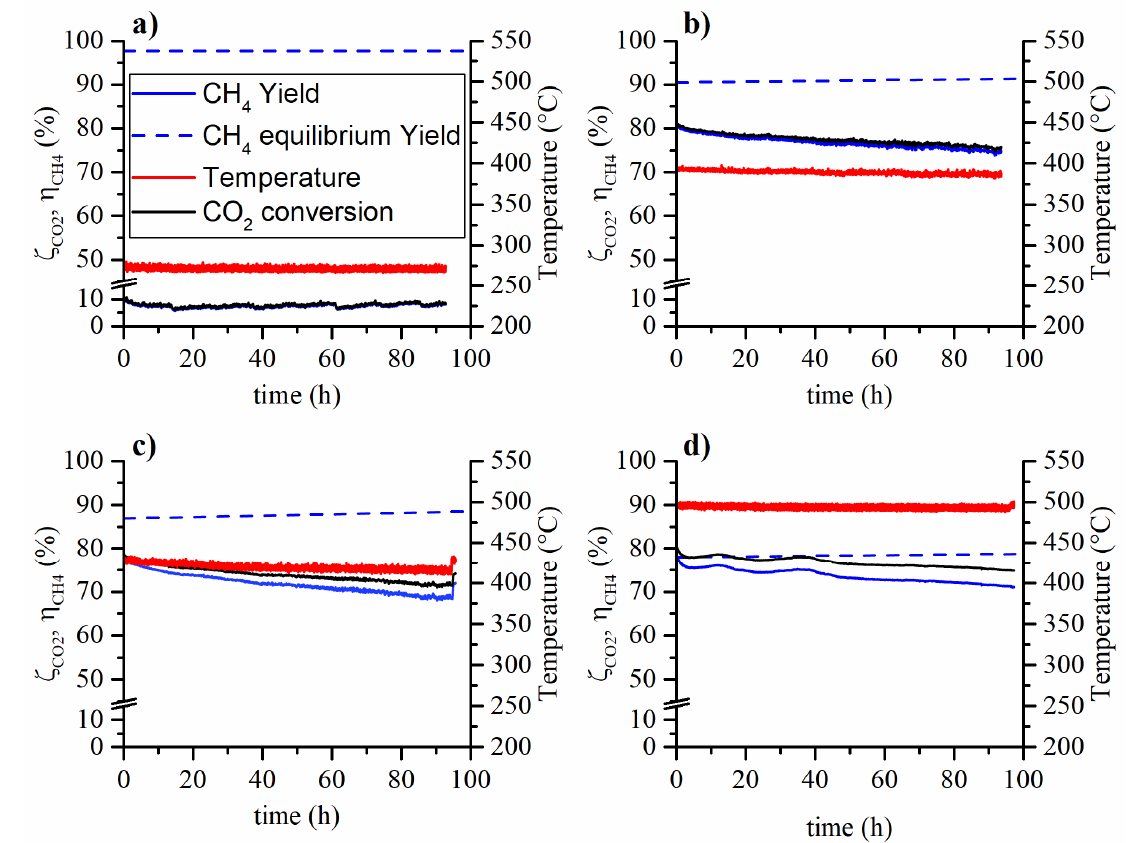
− 1 Figure 2. Aging tests at 5 bar, WHSV = 150 l STP g − 1 h , feed composition 14.8% CO 2 , 59.2% H 2 , 6% Figure 2. Aging tests at 5 bar, WHSV=150 l STP g cat - 1 h - 1 , feed composition 14.8% CO 2 , 59.2% H 2 , 6% CH 4 cat CH 4 and 20% N 2 at 5 bar and ( a ) 270 ◦ C, ( b ) 380 ◦ C, ( c ) 425 ◦ C and ( d ) 500 ◦ C. and 20% N 2 at 5 bar and ( a ) 270 °C, ( b ) 380 °C, ( c ) 425 °C and ( d ) 500 °C. Table 1. CO 2 conversion and Methane yield variation after 100 h of time on stream (Tests 1 and 2 refer to Figures 1 and 2 conditions,